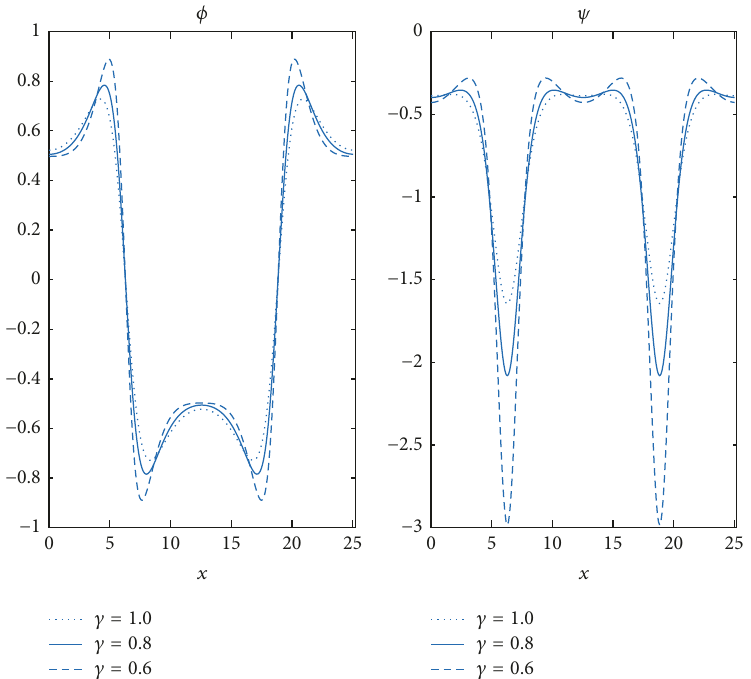
Figure 14: Comparison of periodic travelling wave solutions of the SBO system for different values of the parameter 𝛾 .